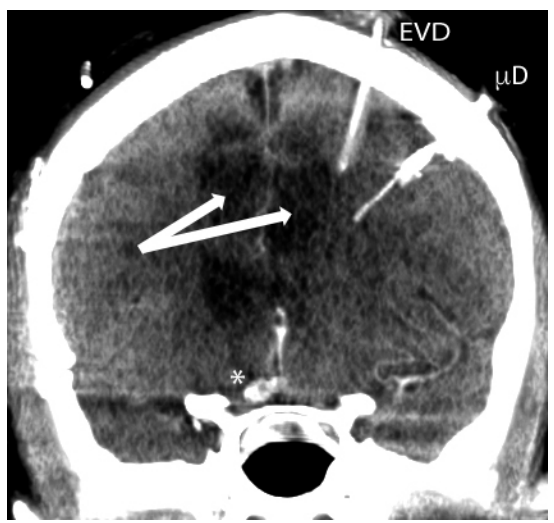
Figure 1. Computed tomography showing External ventricular drain (EVD) and microdialysis (µD) probe in place in aSAH patient. Sometimes the multimodality monitoring probes are in proximity to injured brain, but often they are not. Severe vasospasm resulting in ischemic brain (arrows) occurred days after anterior communicating artery aneurysm clipping (*).